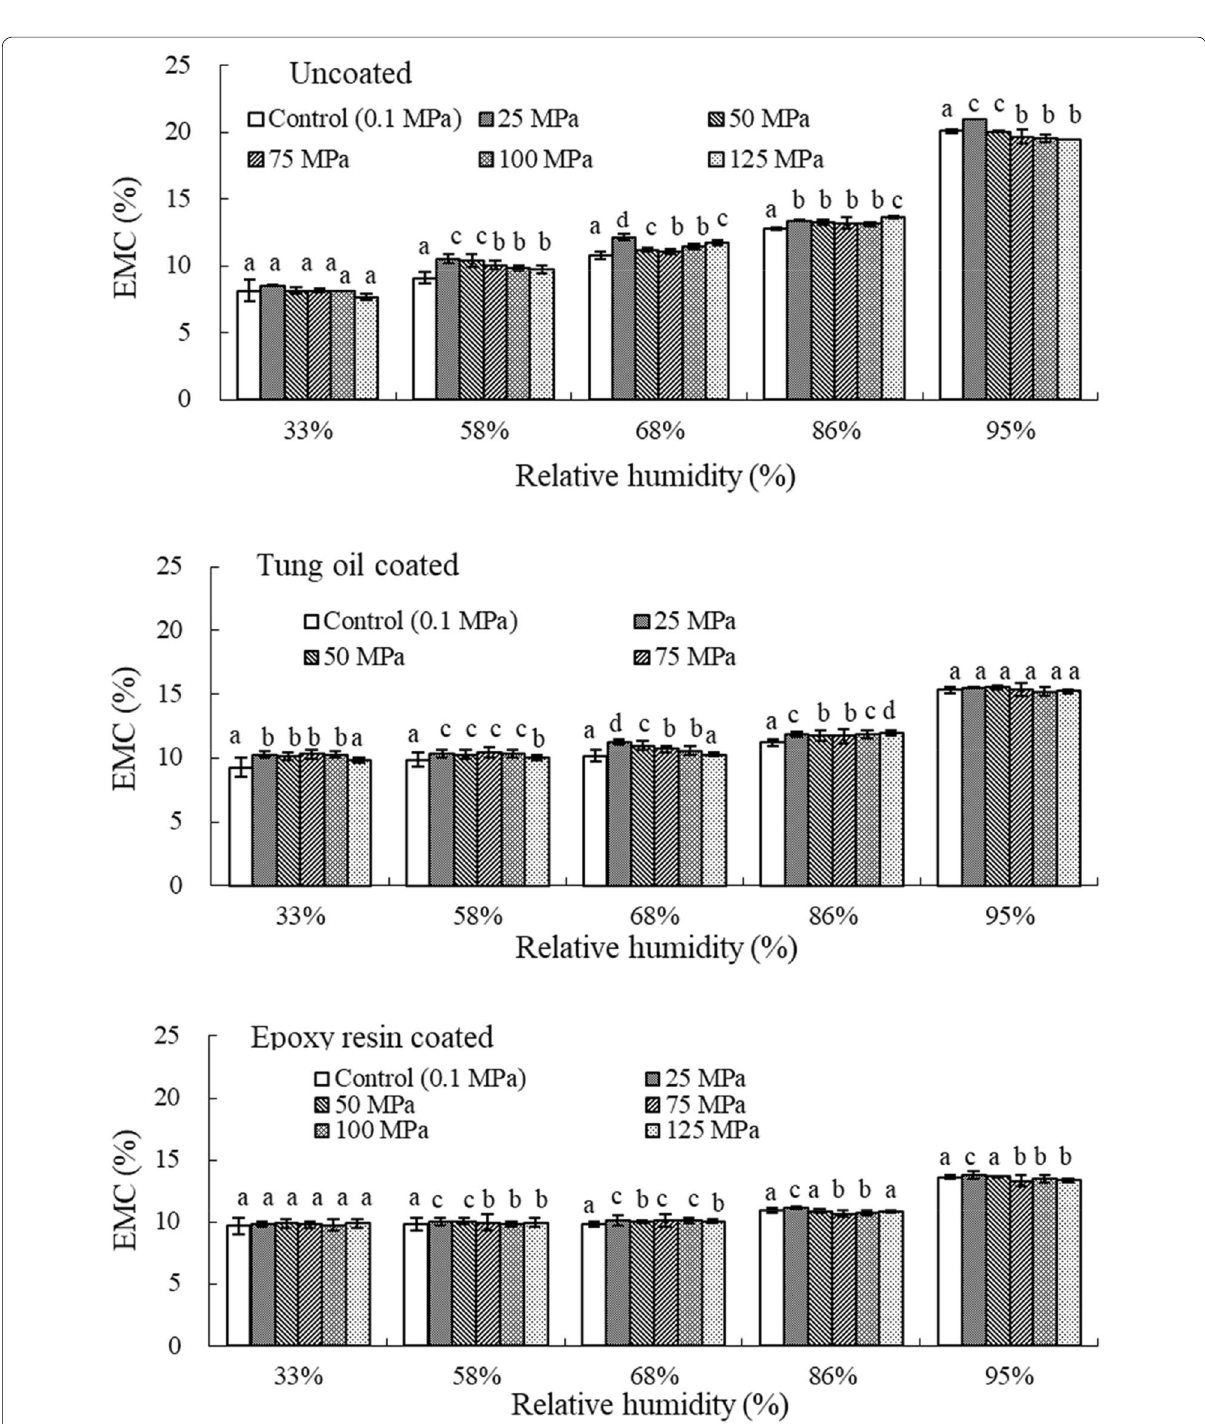
Fig. 8 EMC of uncoated treated, TO-coated treated and ER-coated treated wood samples under different RH environments at 25 °C (error bars present standard deviations, and letters mean significantly different levels at p